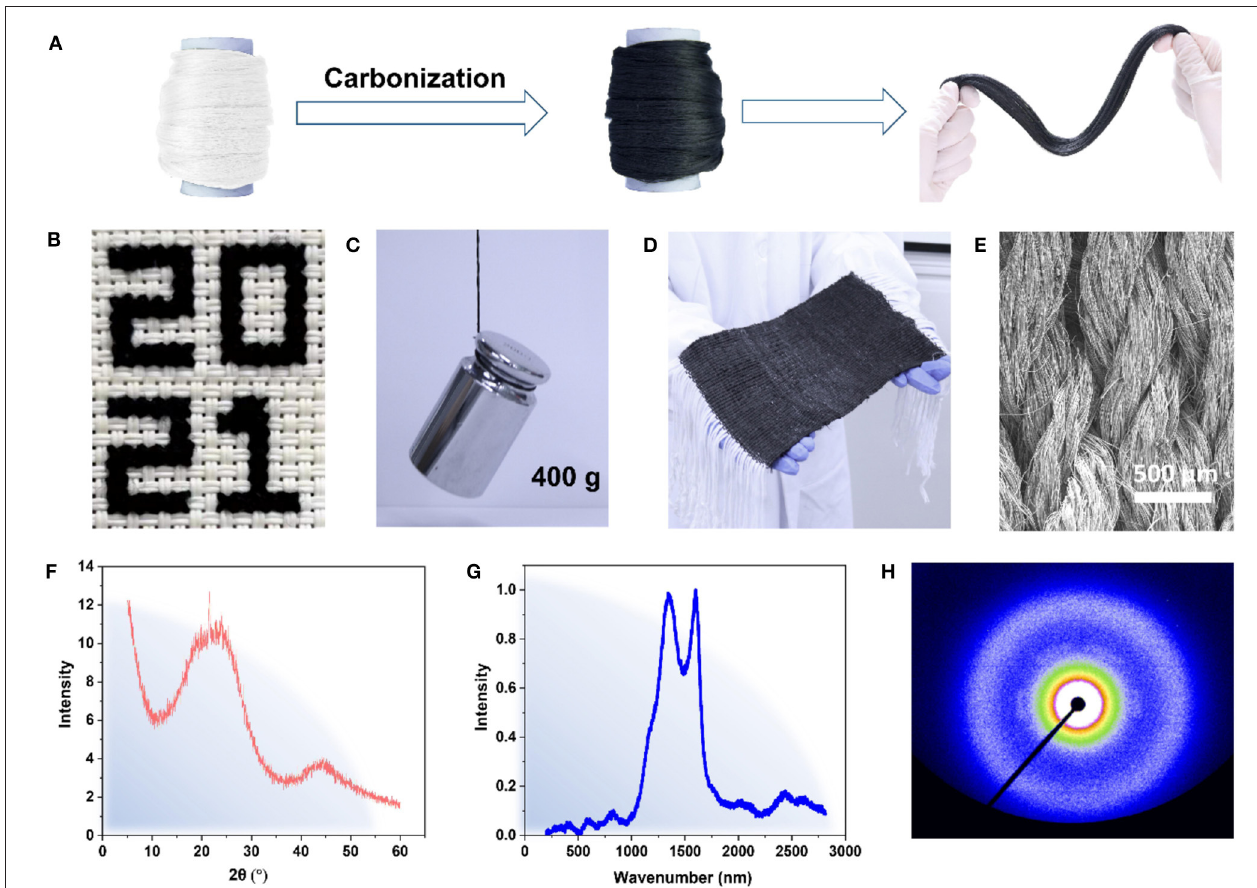
FIGURE 1 | (A) The morphology of Bombyx mori ( B. mori ) silks before and after the carbonization; (B) “2021” is knitted by carbonized B. mori silks (CBSs); (C) A weight of 400g is lifted by CBSs (0.1g); (D) A large-scale fabric is made by CBSs and cotton yarns; (E) The scanning electron microscopy (SEM) image of a composite fabric; (F) x-ray diffraction (XRD) spectrum of CBSs at carbonization temperature of 1,000 ◦ C; (G) Raman spectra of CBSs at carbonization temperature of 1,000 ◦ C; and (H) Wide-angle scattering diffraction pattern of CBSs at carbonization temperature of 1,000 ◦ C.